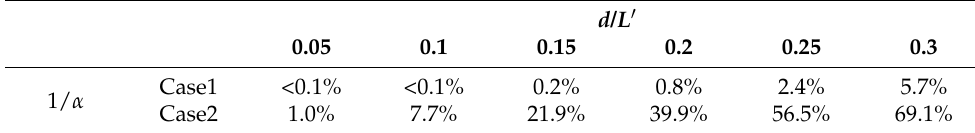
Table 3. Underestimation of nodule abundance due to burial. 1/ α represents the proportion of underestimation of the estimated abundance due to